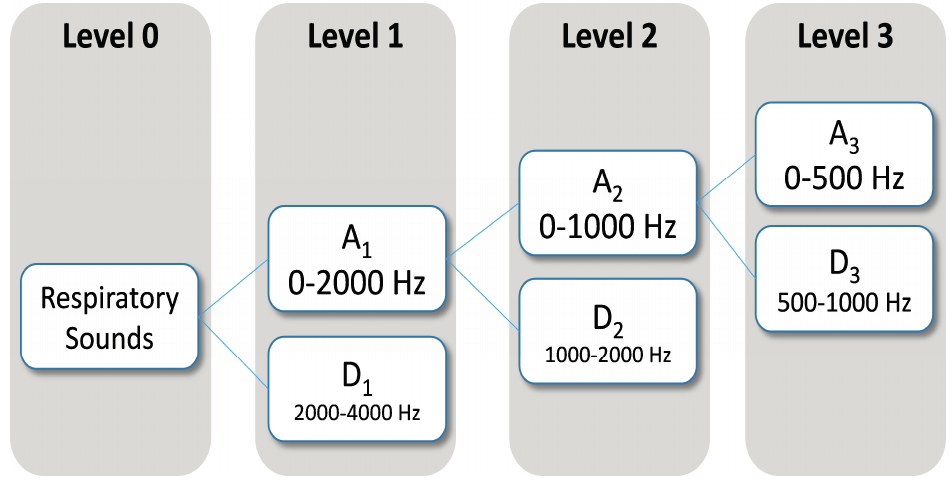
Figure 3. Subband decomposition of Discrete Wavelet Transform implementation. The used subband were A1, A2 and